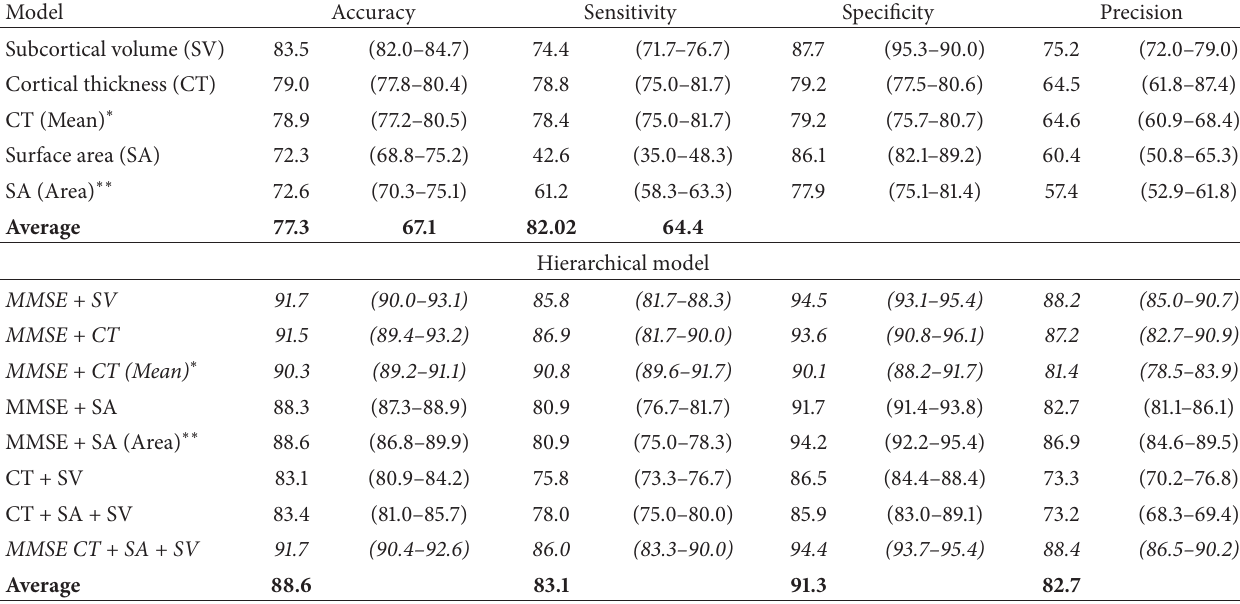
∗ Scaled by the mean thickness of the all the thickness measures. ∗∗ Scaled by the total area of the all the